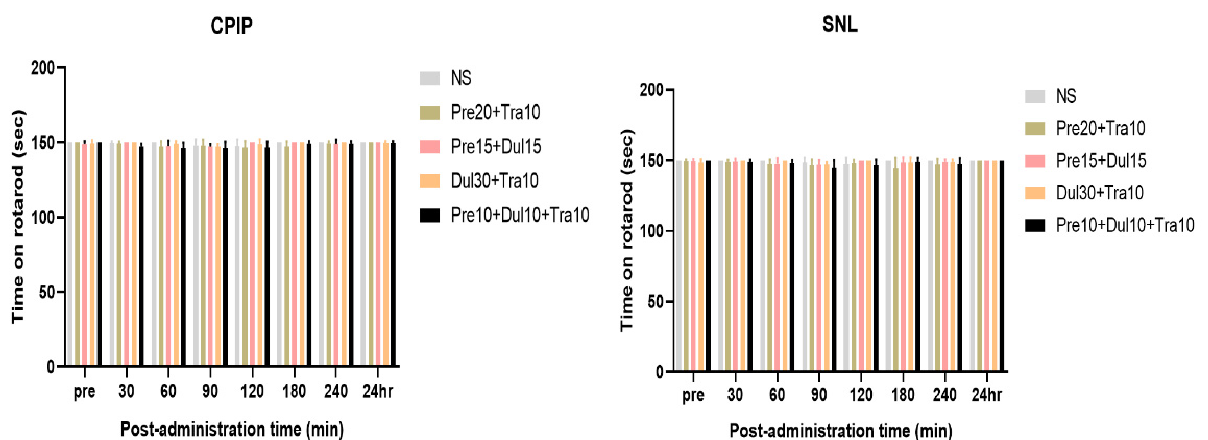
Figure 7. The rotarod time of mixed drugs-injected mice. Rotarod time was observed before (Pre) and after mixed drugs or saline injection. Rotarod time was not decreased by injection of normal saline (NS) and mixed drugs. ( n = 4 in saline group, n = 6 other groups) ( p > 0.9999 vs. NS).